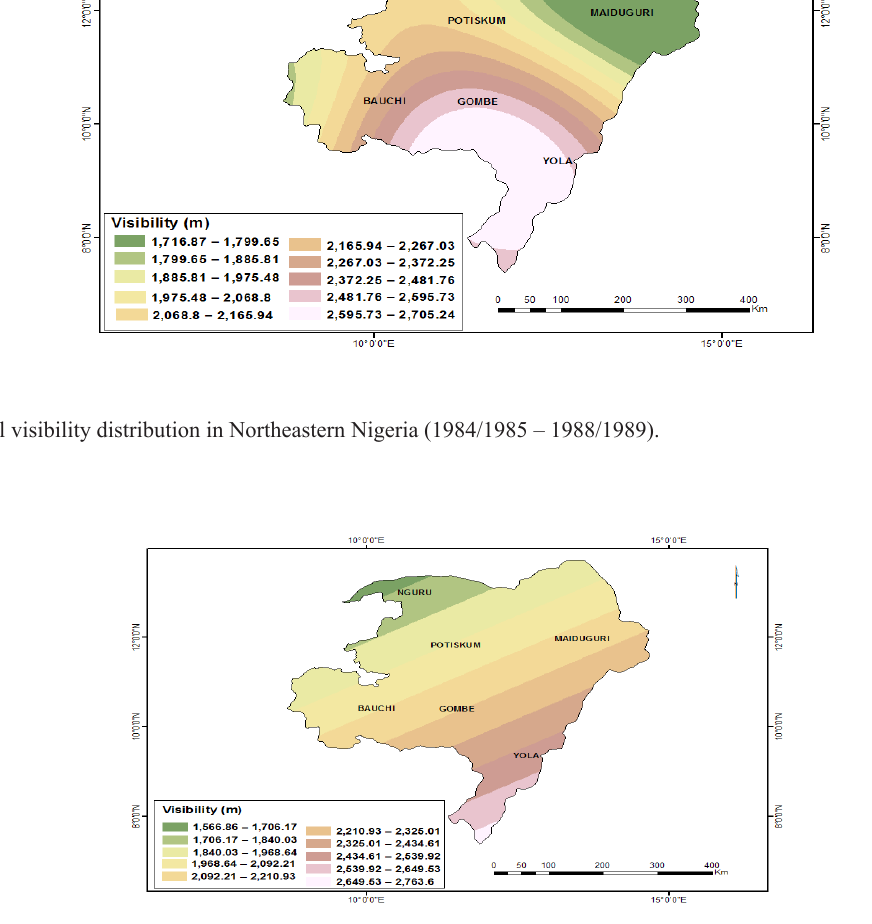
Figure 10: Spatial Air Visibility Distribution in Northeastern Nigeria (1989/1990 – 1993/1994).